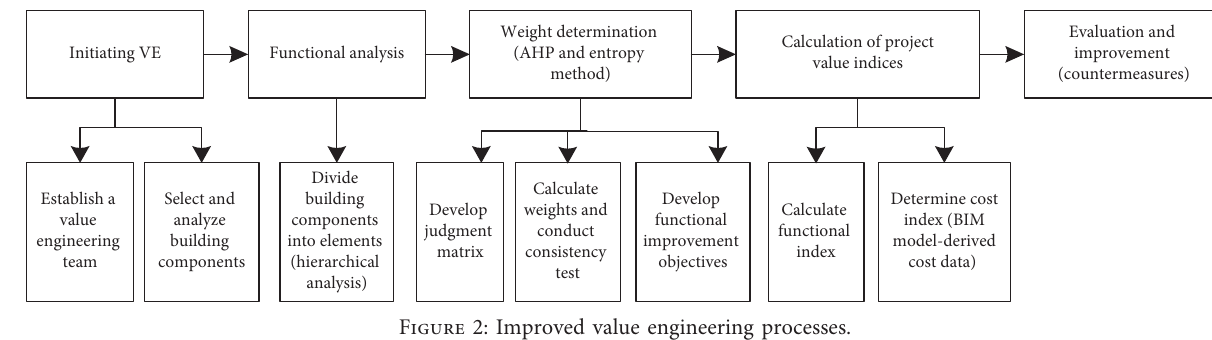
Figure 2: Improved value engineering